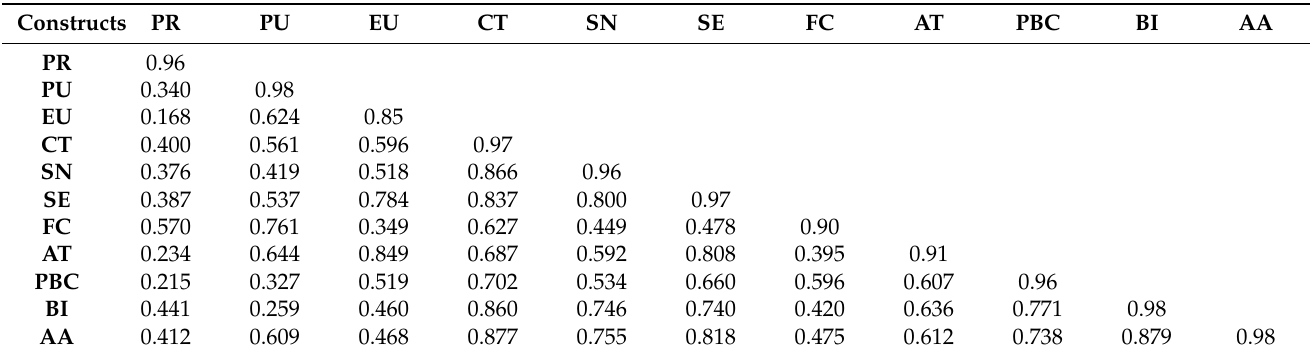
Table 6. Correlations of